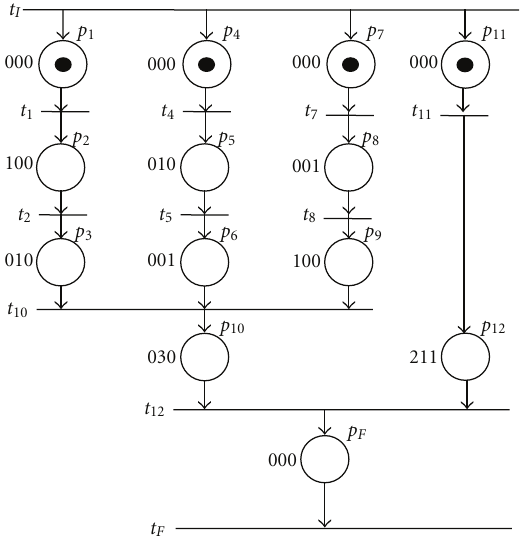
Figure 3: Example assembly